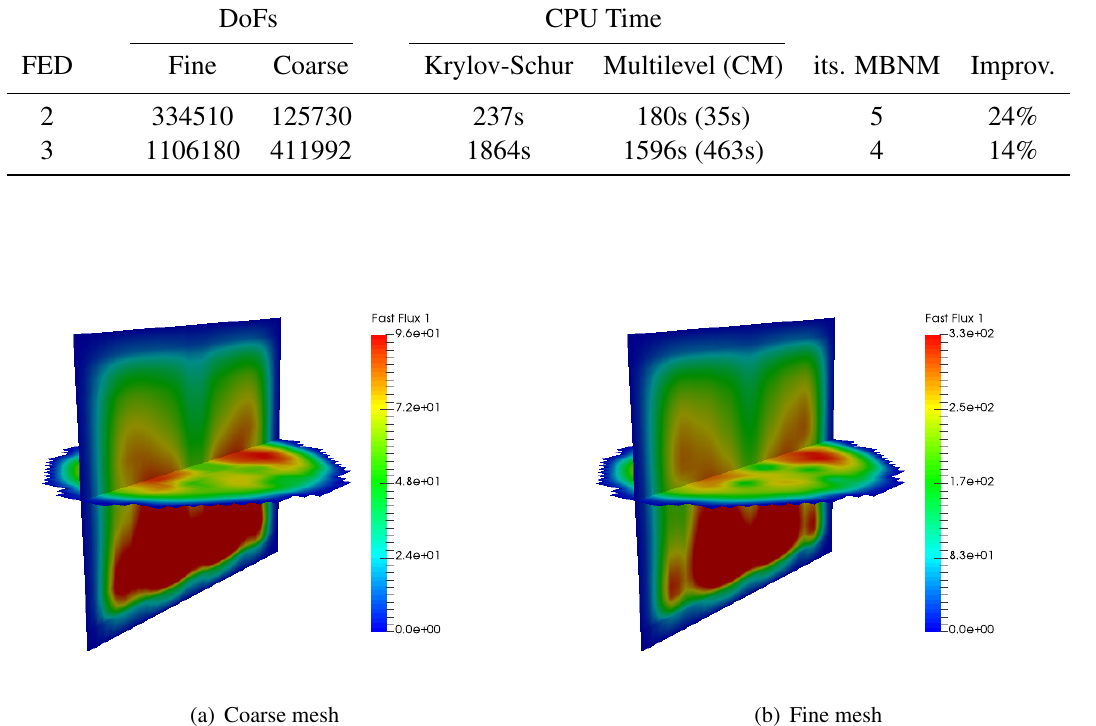
Fig. 3 Fast fluxes associated with the first